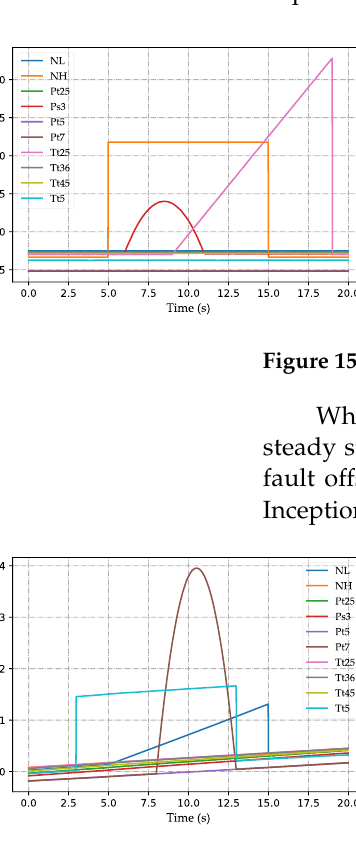
Figure 16. Validation of the FDI process with simultaneous multi-sensor failures in transition